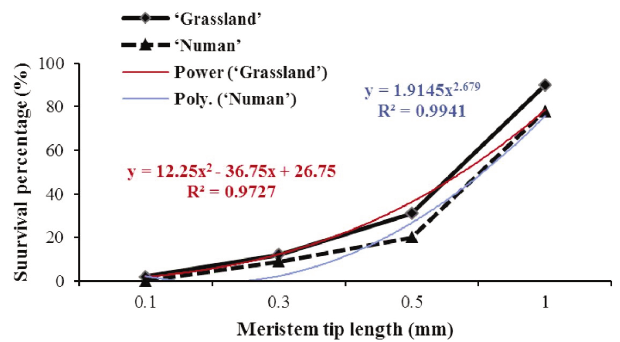
Fig. 4 - Survival percentage as a function of meristem tip length. The red and blue lines are the best fitness for ‘Grassland’ and ‘Numan’,